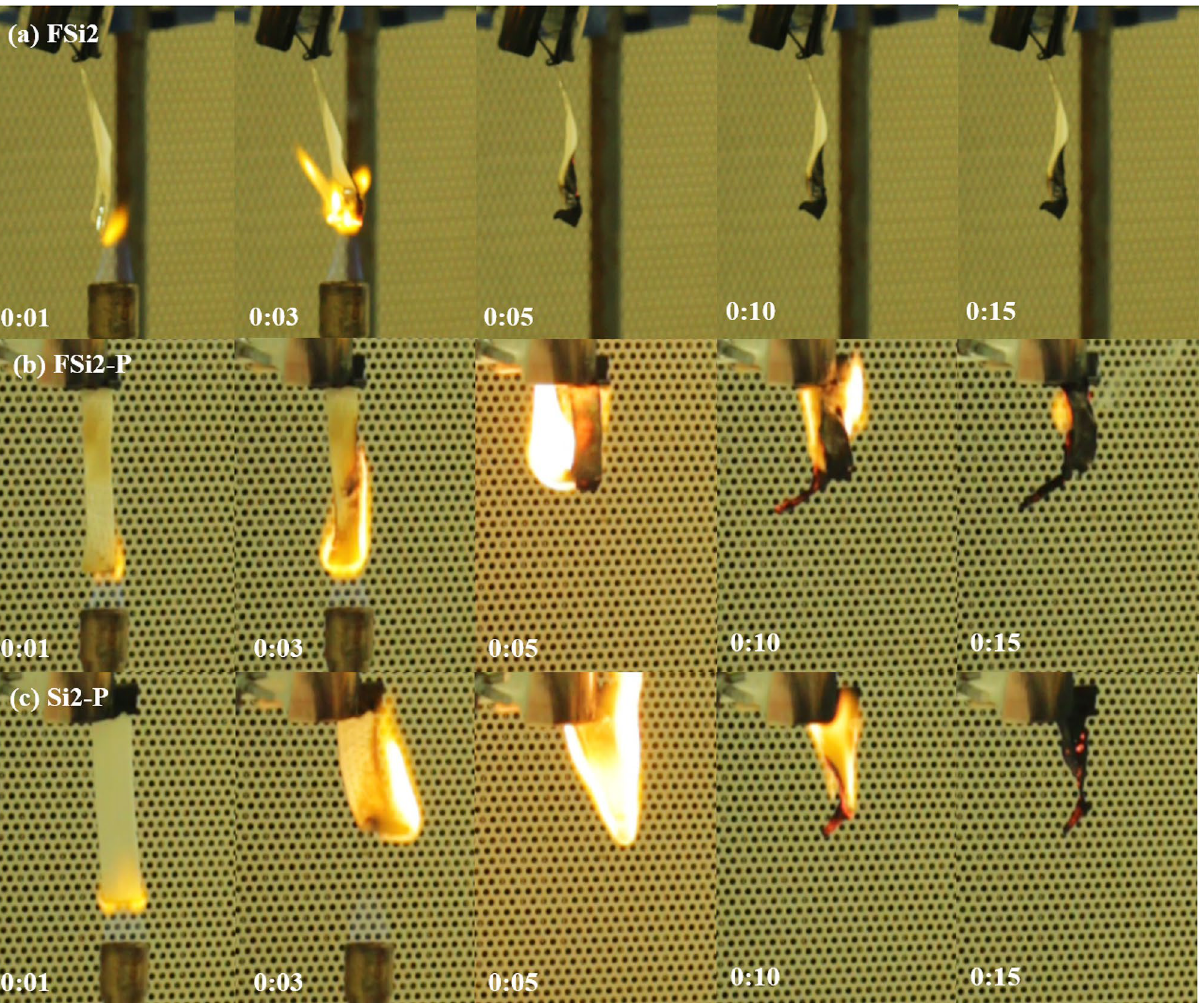
Figure 12. Video screenshots of representative samples ( a ) Partial burning in FSi2 (fungal fibers grown with 2% Si source); ( b ) FSi2-P (fungi-PP fabrics grown with 2% Si source); ( c ) Si2-P (PP fabrics submerged in substrate with 2% Si source) during the upward flame spread